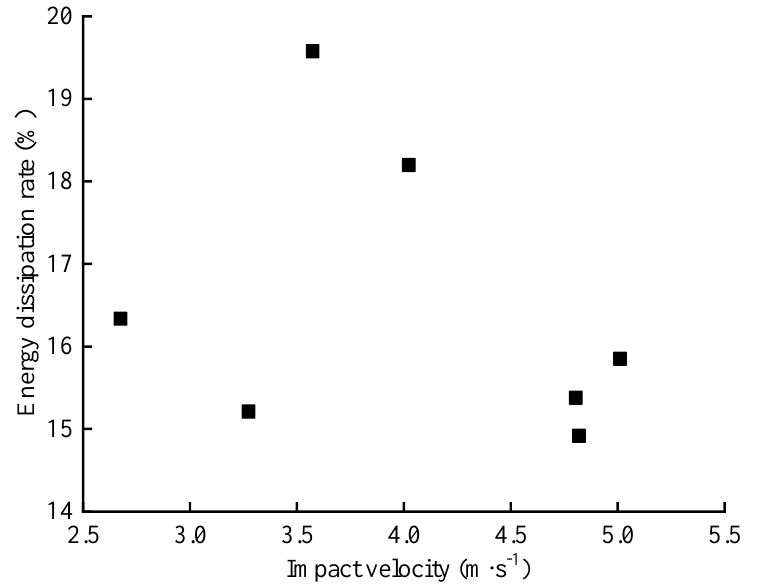
Figure 12. Variation of energy dissipation rate with bullet impact velocity.